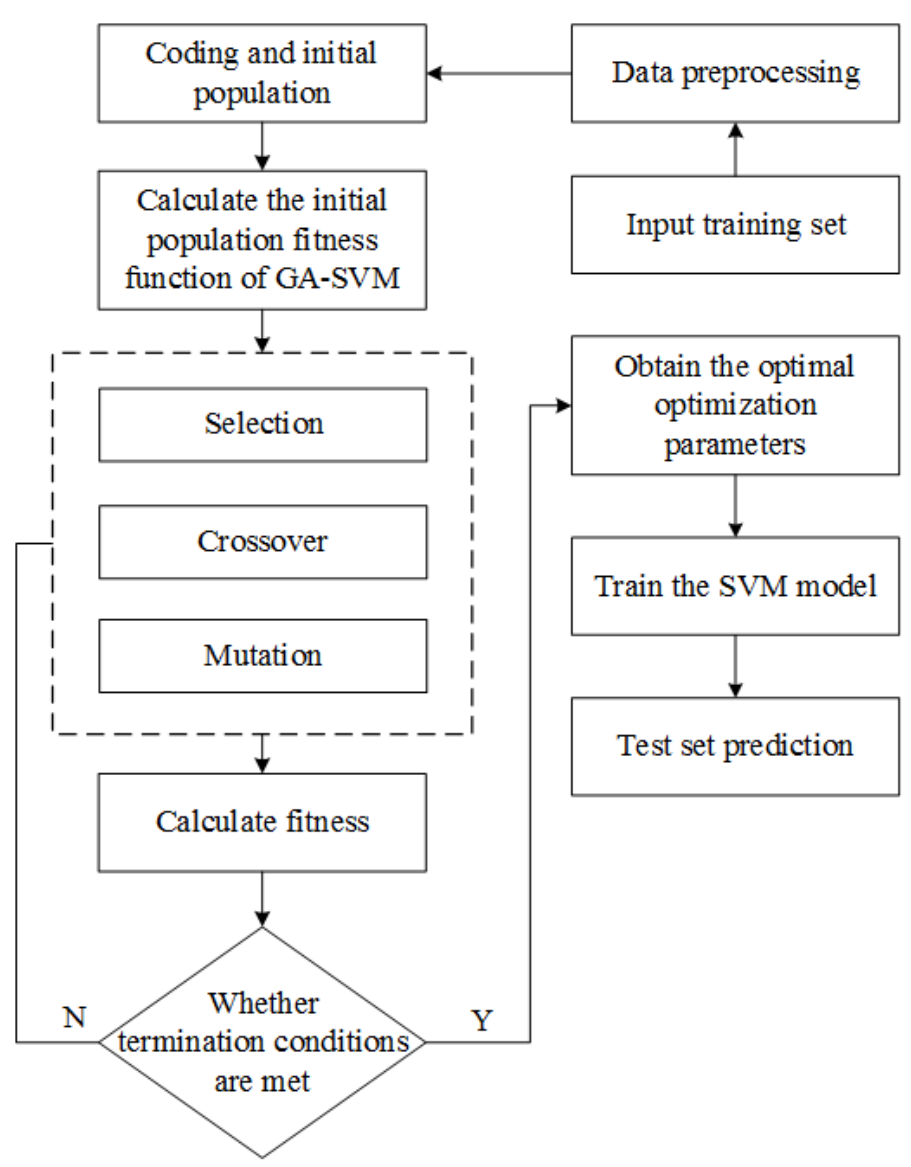
Figure 4. Flowchart of GA-SVM neural network calculation.